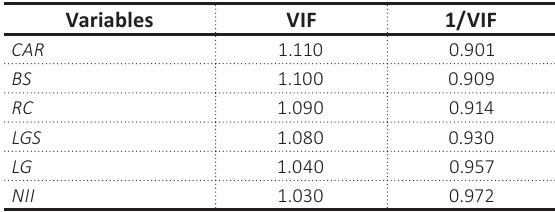
Table 3. Multicollinearity test